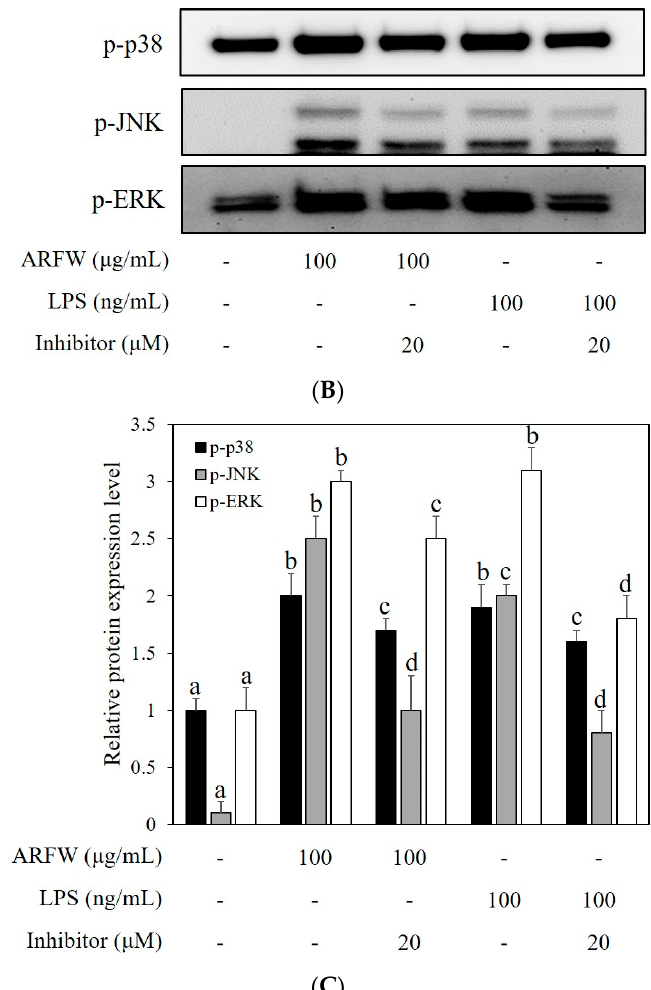
Figure 5. Effect of ARFW on MAPK signaling. Cells were treated with ARFW or LPS (100 ng/mL) for 30 min and MAPK protein expression levels were determined by western blot analysis with specific antibodies ( A ). Cells were treated with ARFW or LPS (100 ng/mL) in the presence of MAPK inhibitors for 30 min and MAPK protein expression levels were determined, Cells were treated with 20 μ M of the MAPK inhibitor SB203580 (p38 inhibitor), SP600125 (JNK inhibitor), and PD098059 (ERK inhibitor) ( B , C ).